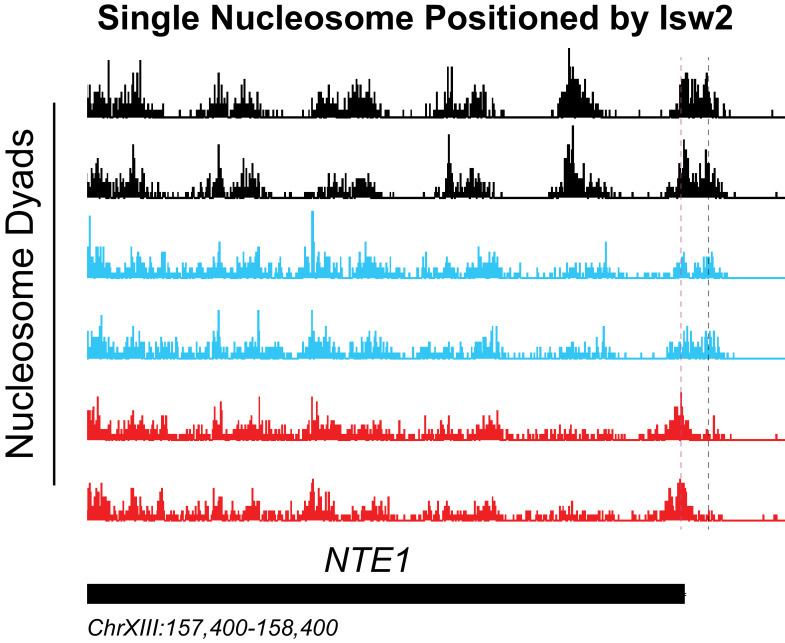
Isw2 is a precise specialist at target nucleosomes.Example Isw2 target locus where addition of Isw2 in the absence of Isw1 and Chd1 leads to positioning of a single motif-proximal nucleosome at the NTE1 locus. Vertical gray dashed lines indicate the wild-type nucleosome locations while vertical dashed pink lines indicate an alternate isw2 deletion strain position at the motif-proximal nucleosome. The ISW2/chd1/isw1 strain can position the motif-proximal nucleosome, but all distal nucleosomes are disorganized much like the isw2/chd1/isw1 strain.